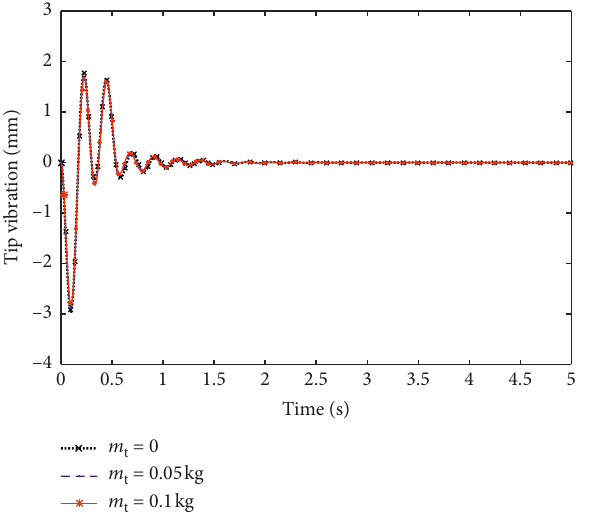
Figure 12: Control effects of the master-slave composite controller on the elastic vibration of the MFMS under variable load conditions.